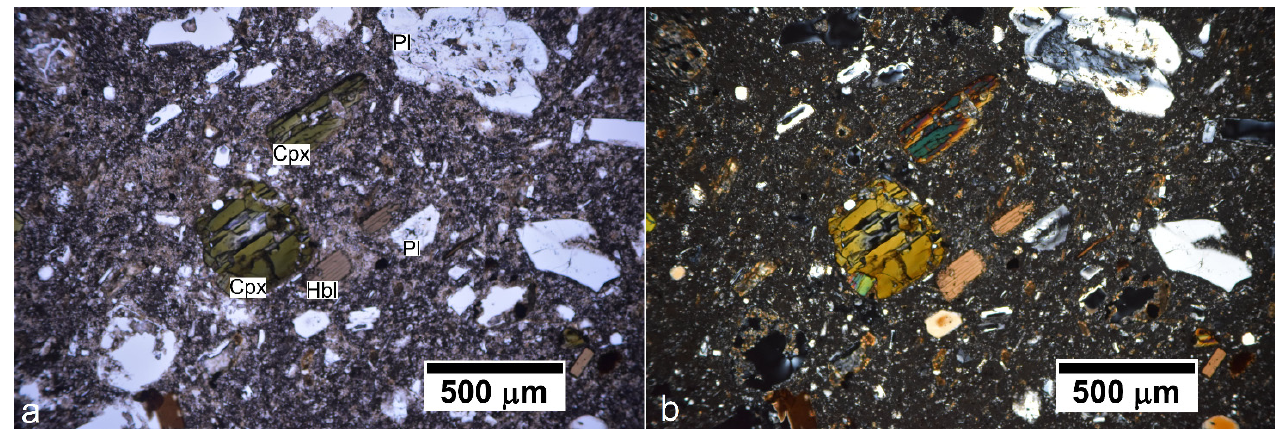
Figure 2. Transmitted light petrographic images under ( a ) plain-polarized, and ( b ) crossed-polarized light. Two big clinopyroxene (Cpx) phenocrystals, probably augite, abundant plagioclase (Pl), and some brown hornblende crystals surrounded by a sericitized groundmass are observed.